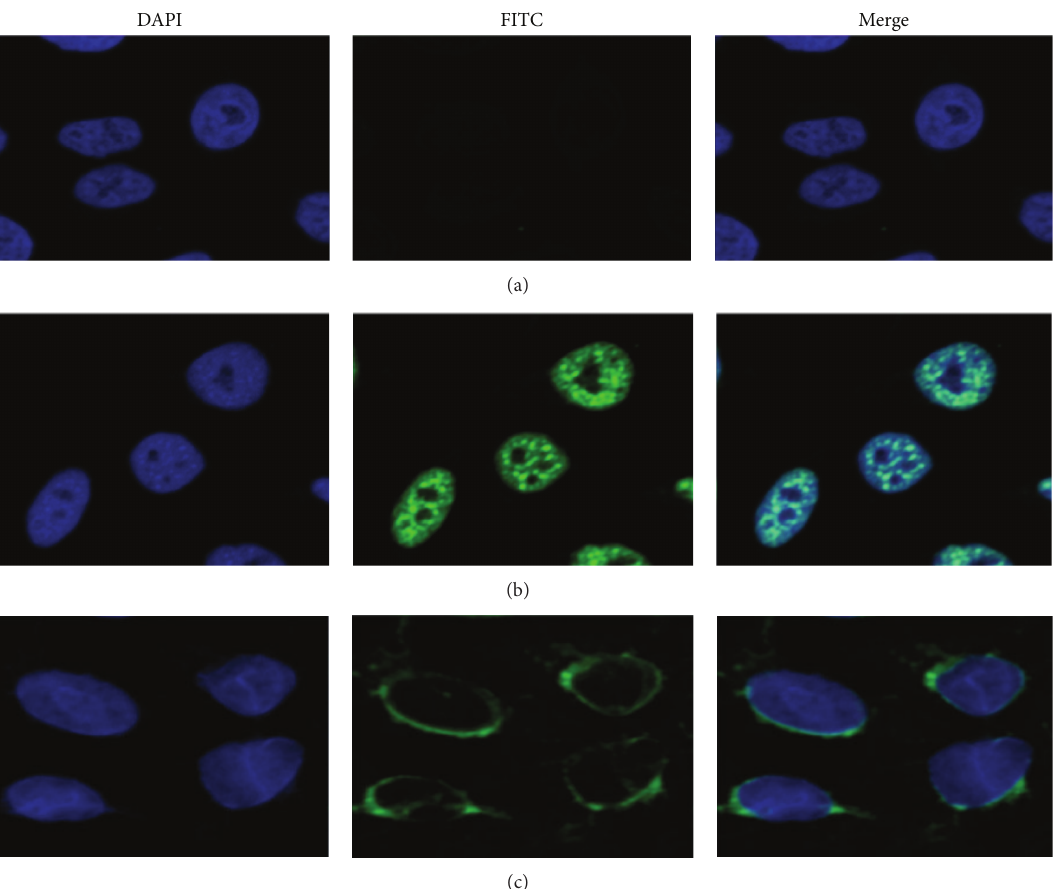
Figure 3: Representative immunofluorescence staining pattern from a SLE serum with anti-MDM2 autoantibody positive (performed on Hep-2 antinuclear antigen tissue slides). (a) NHS was used as negative control; (b) a representative SLE serum with anti-MDM2 autoantibody positive demonstrated an intense nuclear staining pattern; (c) the same SLE serum used in panel (b) was preabsorbed with recombinant MDM2, and the nuclear fluorescent staining was significantly reduced.